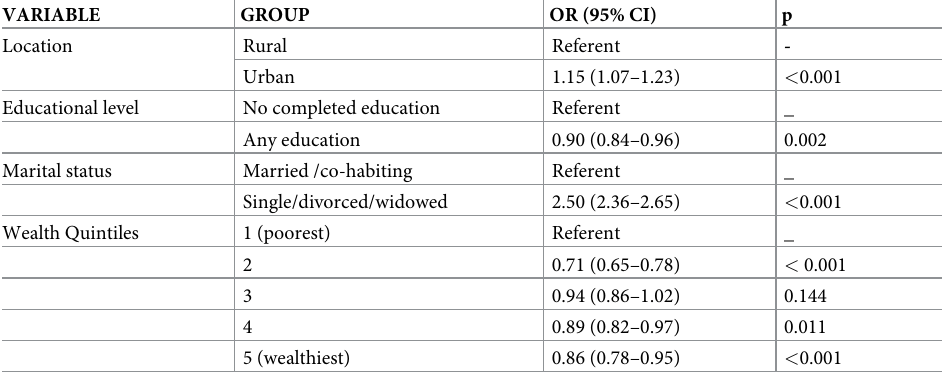
Table 2. Multivariable associations between weighted demographic characteristics and being at high CVD risk ( > 20%) (n =